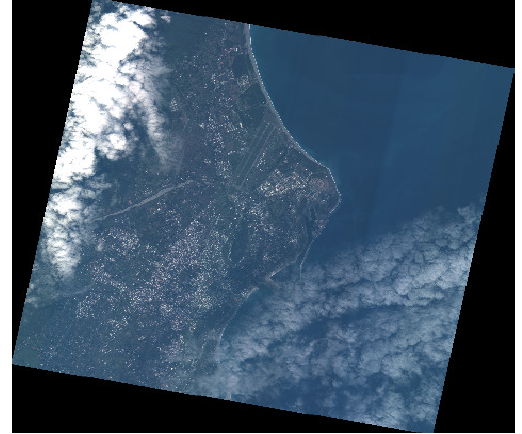
Figure 8. Initial image of the Hualian city (Taiwan) from the SuperView-1A satellite for January 18, 2018 The results of the automated recognition of vegetation and water objects for two test sites on the images of the Hualian city with the same settings of binarization thresholds are shown in the figure 9.